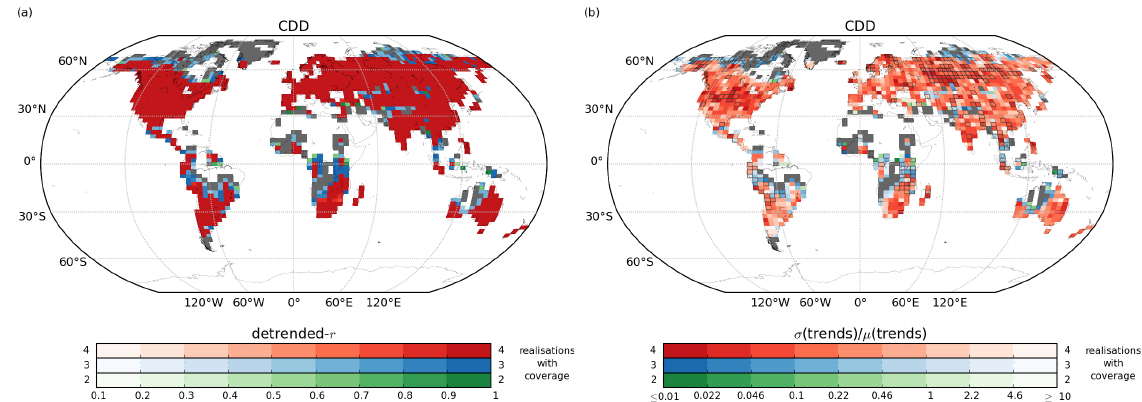
Figure 14. (a) The mean correlation coefficient of the detrended time series, r with HadEX2 for all the grid boxes and (b) the standard deviation of the trends divided by the mean trend ( σ/µ ) calculated for the period 1951 to 2010 for CDD and the number of stations per grid box. Grey grid boxes are those where only one of the four possible DLS calculation choices results in a value, green when two, blue when three, and red when all four. For further details see Fig. 5.